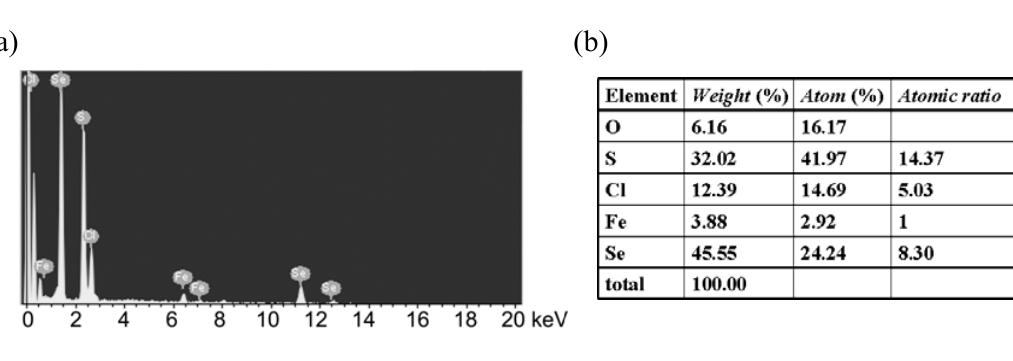
Figure 17. (a) SEM − EDX spectrum of ( EDT − EDSe − DSDTFVS )